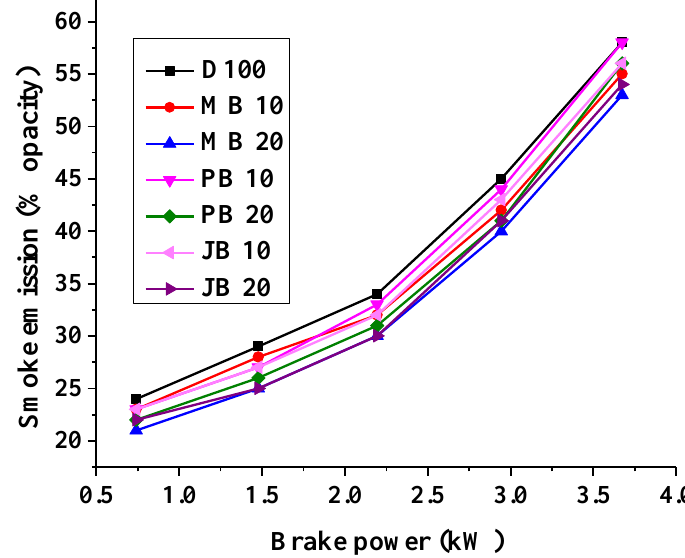
Figure 7. Comparison of smoke emission with respect to engine loading for different fuels.